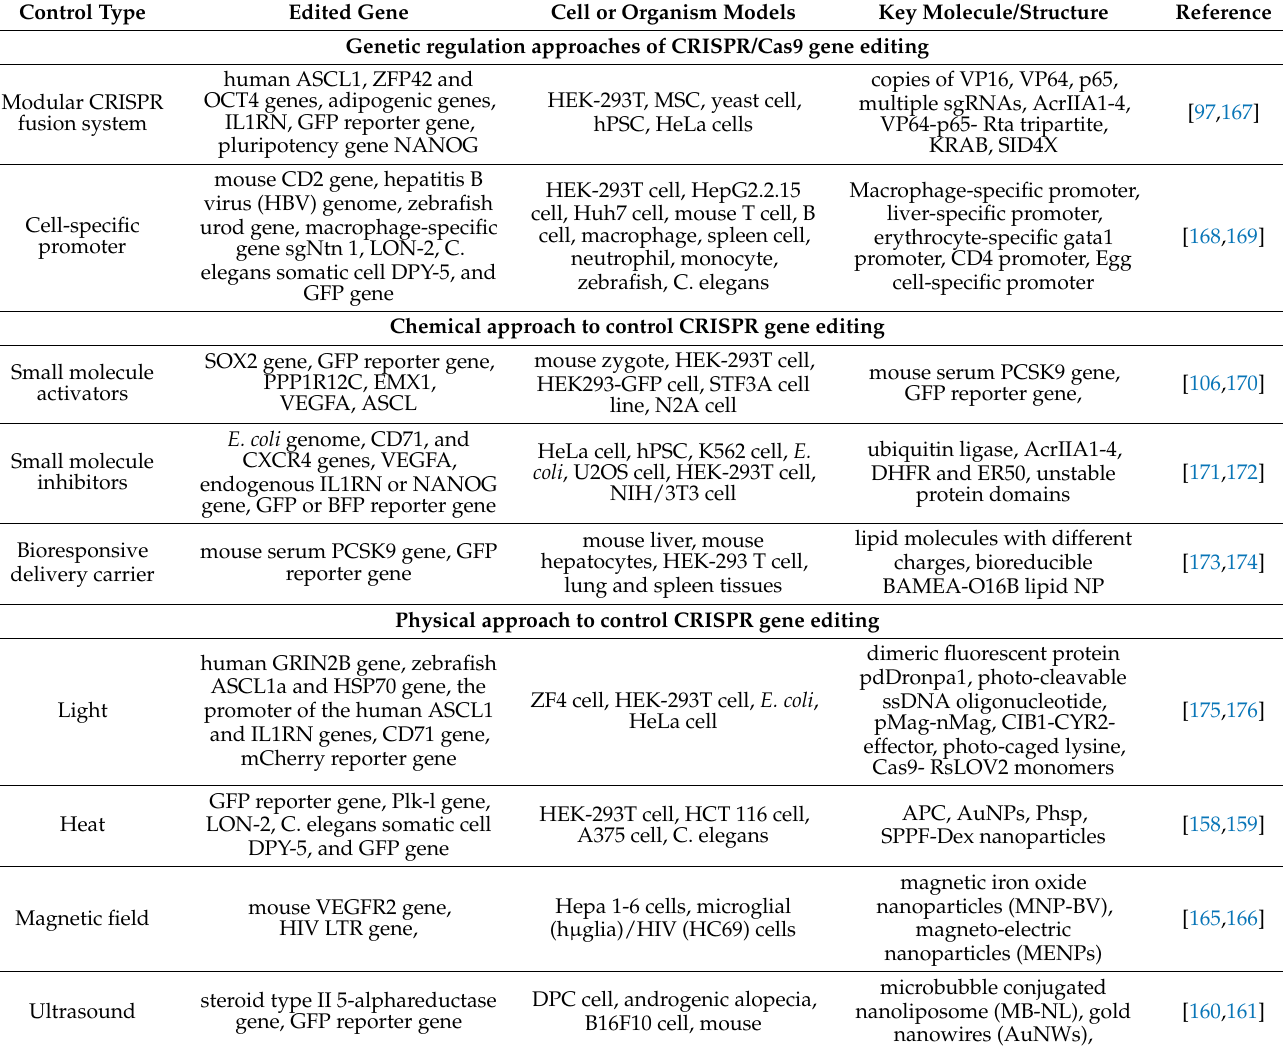
Table 3. Examples of genetic regulation, chemical control, and physical control approaches for CRISPR gene